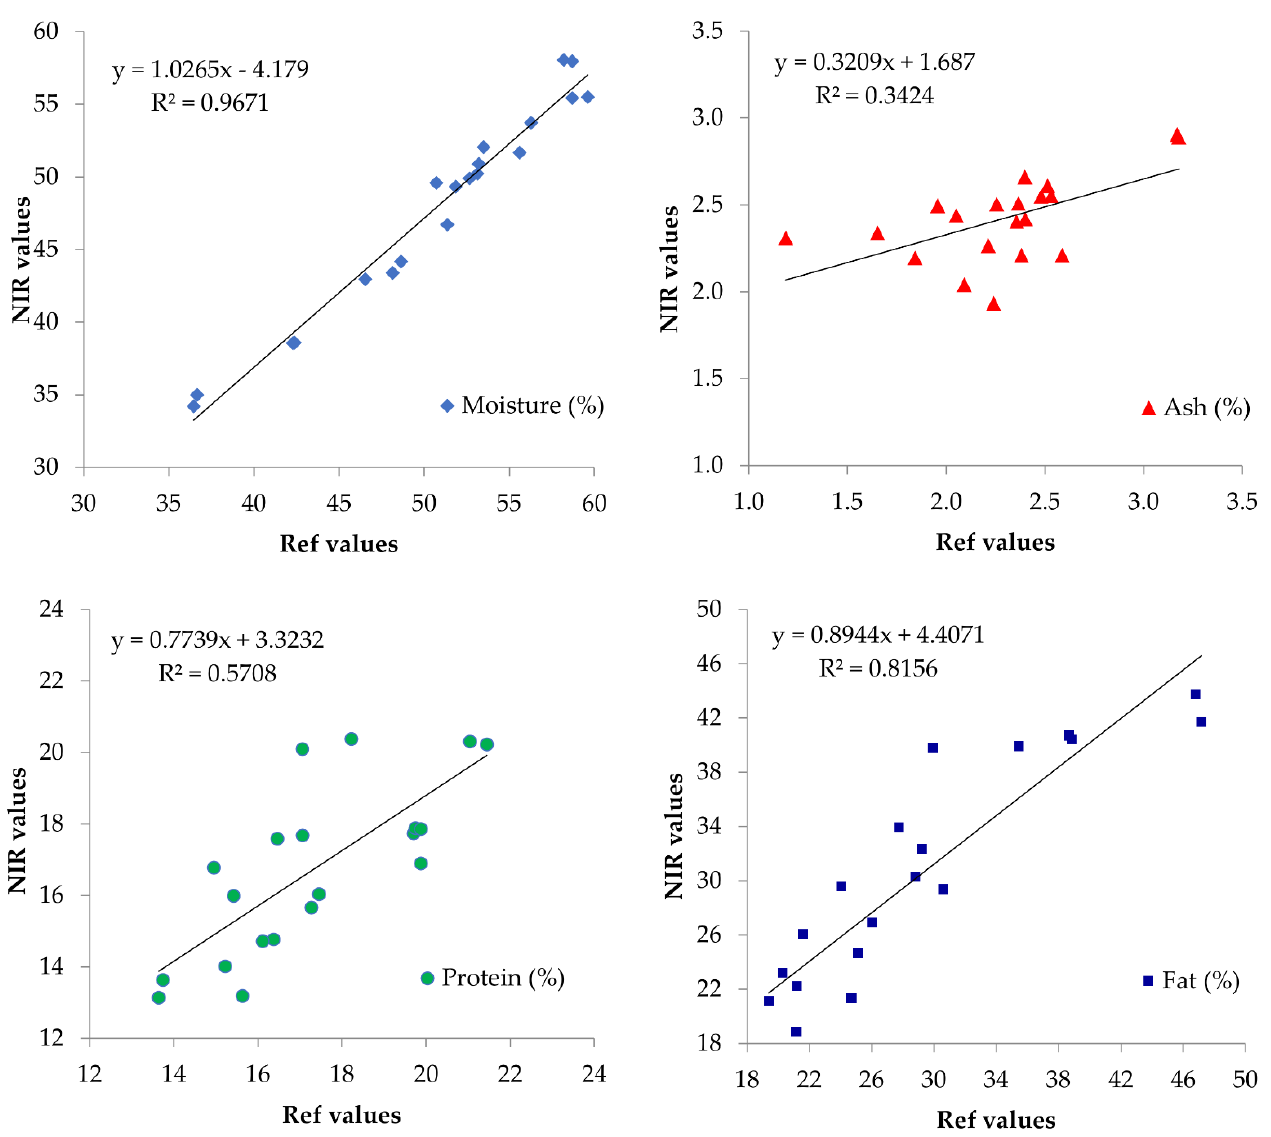
Figure 3. Regression values for measured (Ref) and estimated (NIR) values for moisture, ash, protein, and fat content of traditional sausages used for the external validation.